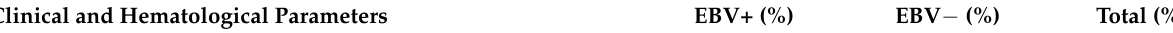
Table 4. Frequency of clinical and hematological parameters in patients affected by systemic lupus erythematosus (SLE) (group A) tested positive or negative for Epstein–Barr virus (EBV) in salivary samples. Clinical and Hematological